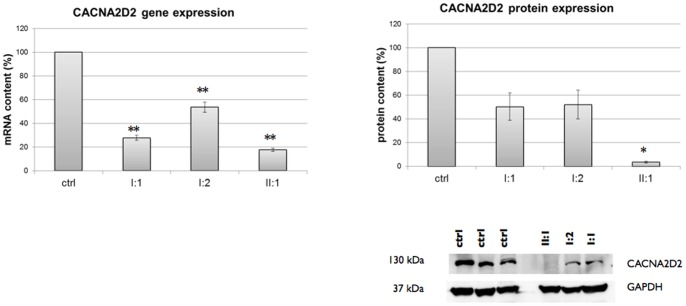

CACNA2D2 mRNA and protein expression.Left panel: the mRNA content of the proband was evaluated by Real Time-PCR and normalized on that of control individuals (n = 4). CACNA2D2 mRNA resulted strongly reduced in the proband (II:1, 18%), father (I:1, 28%) and mother (I:2, 54%) compared to controls (Anova test, p<0.001). Data are shown as mean ± standard error of three independent experiments. Right panel: the protein content was evaluated by Western blot and normalized on that of control individuals (n = 3), using GAPDH as reference protein and loading control. Graph shows data obtained by densitometric analysis. The proband (II:1) showed a 3% of protein expression compared to controls (Anova on Ranks test, p = 0.034), whereas both parents (I:1 and I:2) had ∼50% of expression. Data are expressed as mean ± standard error of three independent experiments. Representative western blot is shown.